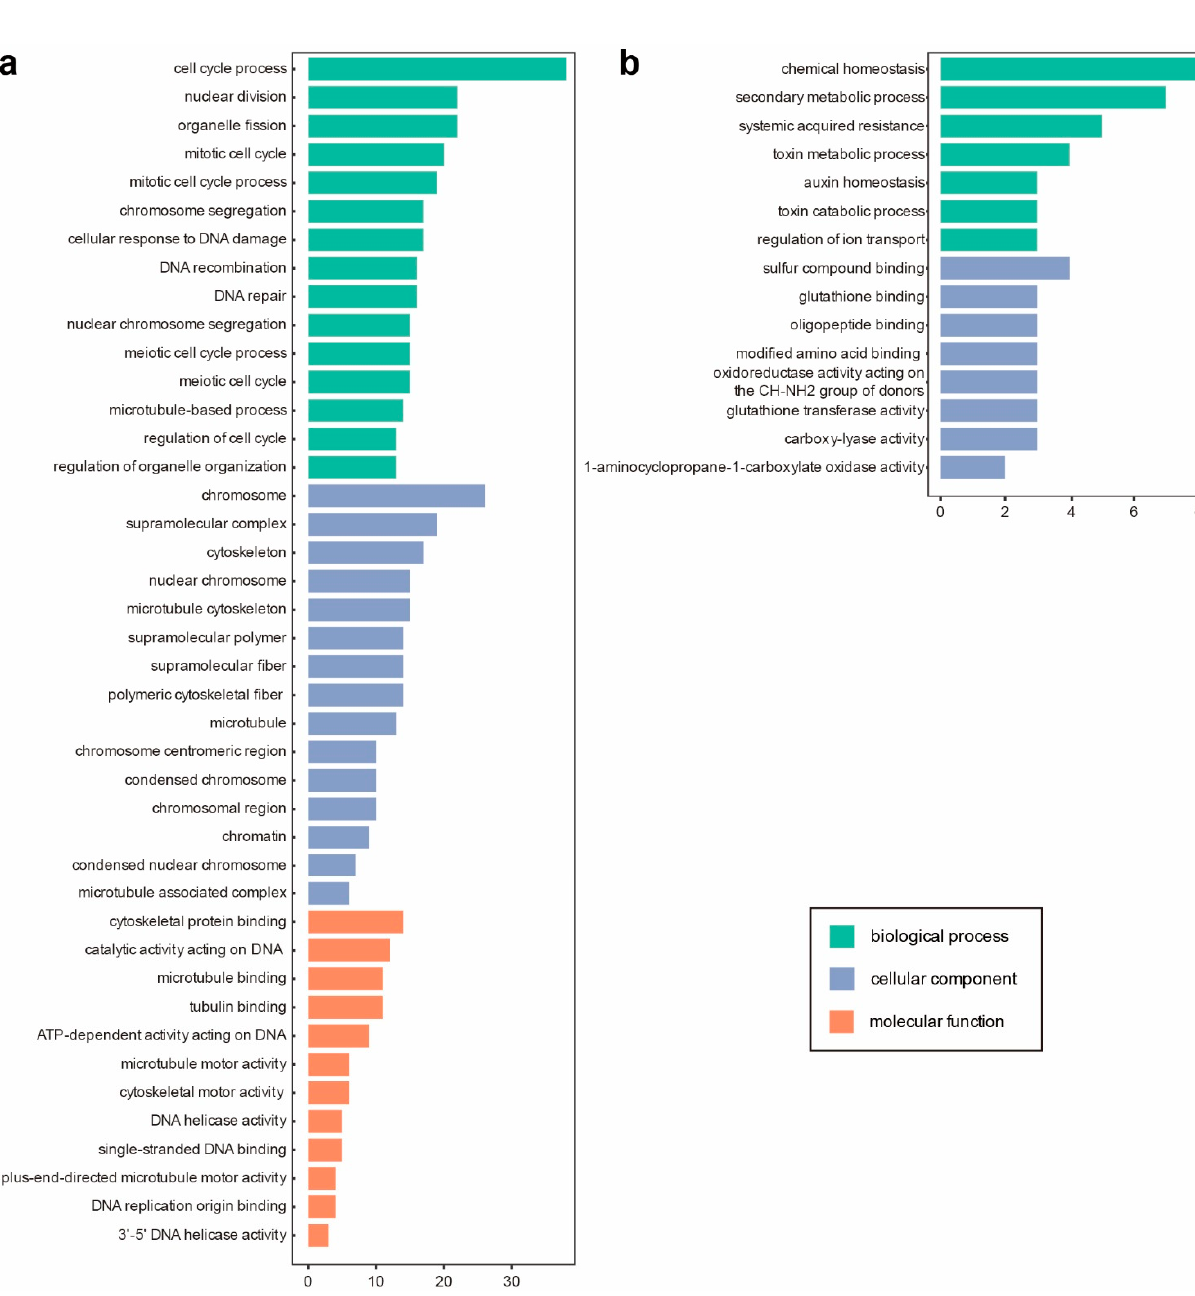
Figure 2. Gene ontology (GO) terms of differentially expressed genes (DEGs) overlapped in asymp- tomatic infection in Col- Δ 2b and Col-2aT Δ 2b. ( a ) Top 15 GO terms enriched for induced DEGs. ( b ) GO terms enriched for suppressed DEGs. The y-axis represents the enriched GO term, and the x-axis represents the number of DEGs in the term. Different colors are used to distinguish biological processes, cellular components and molecular functions.